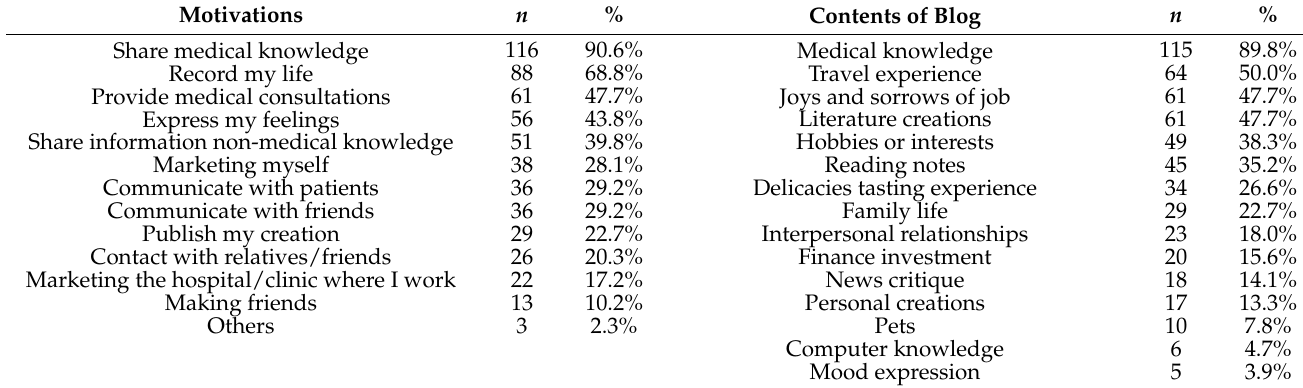
Table 2. Physicians’ Motivations to Blog and the Contents of Their Blogs.